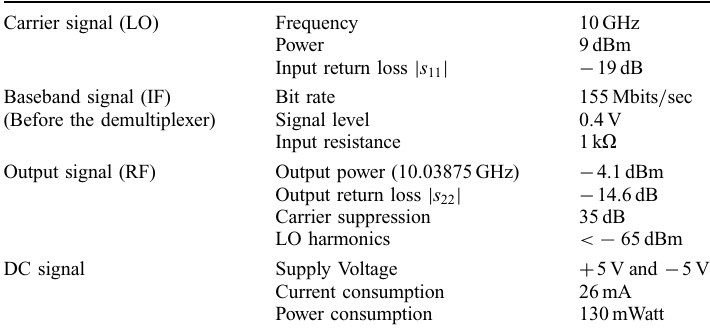
TABLE VII Specifications of the QPSK